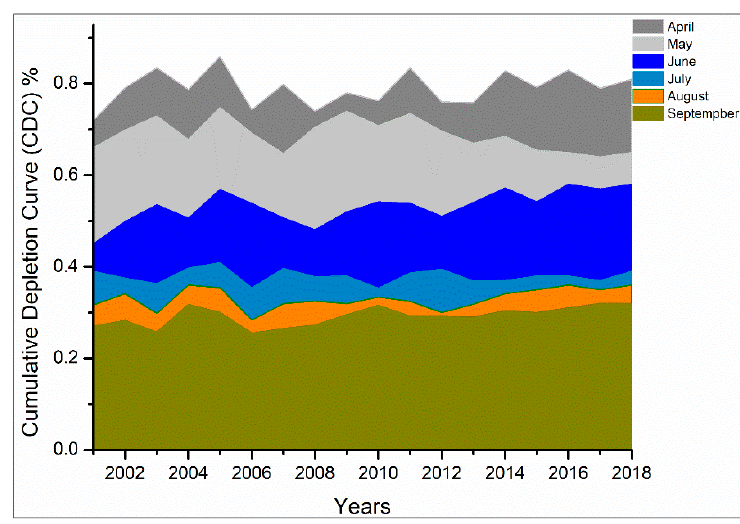
Figure 7. Monthly snow cover variation in ablation period (April-September) during 2001–2018 in the Gilgit River Basin (GRB).